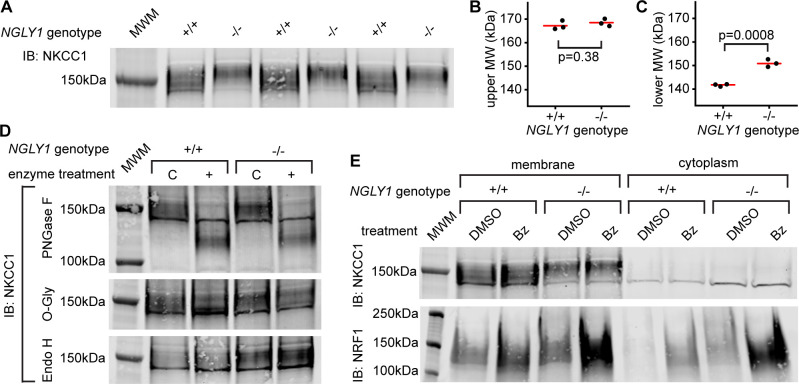
Endogenous NKCC1 is altered in NGLY1-deficient MEFs.(A) Control (+/+) and NGLY1 null (-/-) MEFs were grown to confluency and then lysed to isolate the membrane and cytoplasmic fractions. Three separate membrane lysates for both genotypes were analyzed by immunoblotting for NKCC1 compared to a molecular weight marker (MWM). Blot was used for molecular weight calculations of the upper-most limit (see un-cropped blot in Figure 4—figure supplement 1) (B) And the lower-most limit (C) of the protein band. Red bar represents the mean. Two-tailed t-test was used to calculate p-values. (D) Membrane lysates from MEFs were treated with N-Glycosidase F (PNGase F), O-Glycosidase (O-Gly), or Endoglycosidase H (Endo H) for 1 hr then analyzed by immunoblot. Control (C)Samples were treated in all the same conditions but without the added enzyme. (E) MEFs were treated with 500 nM bortezomib (Bz) or equal volume of vehicle control (DMSO) for 4 hr then lysed to collect membrane and cytoplasmic fractions. Lysates were analyzed by immunoblotting for NKCC1. NRF1 was analyzed as a positive control of proteasome inhibition. Dark band at about 140 kDa in both (A), (D), and (E) is believed to be non-specific.